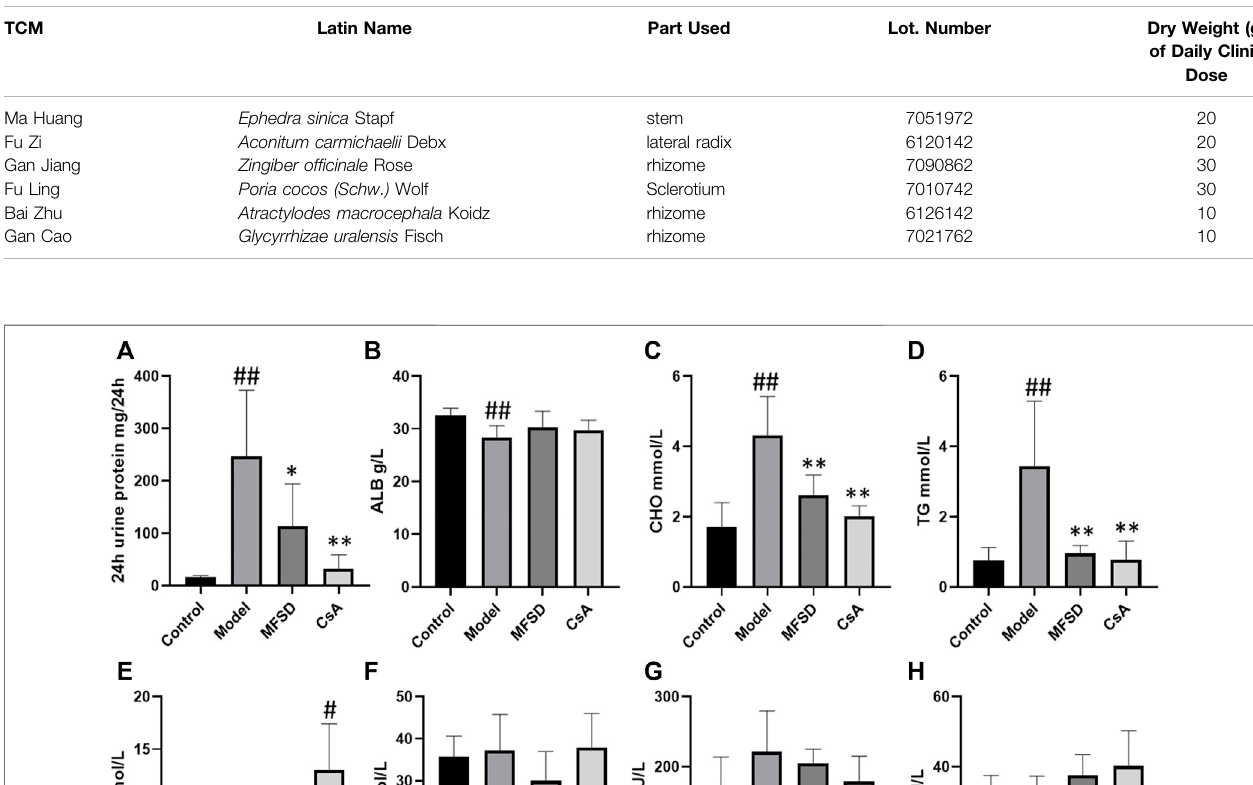
TABLE 1 | The composition of MFSD.